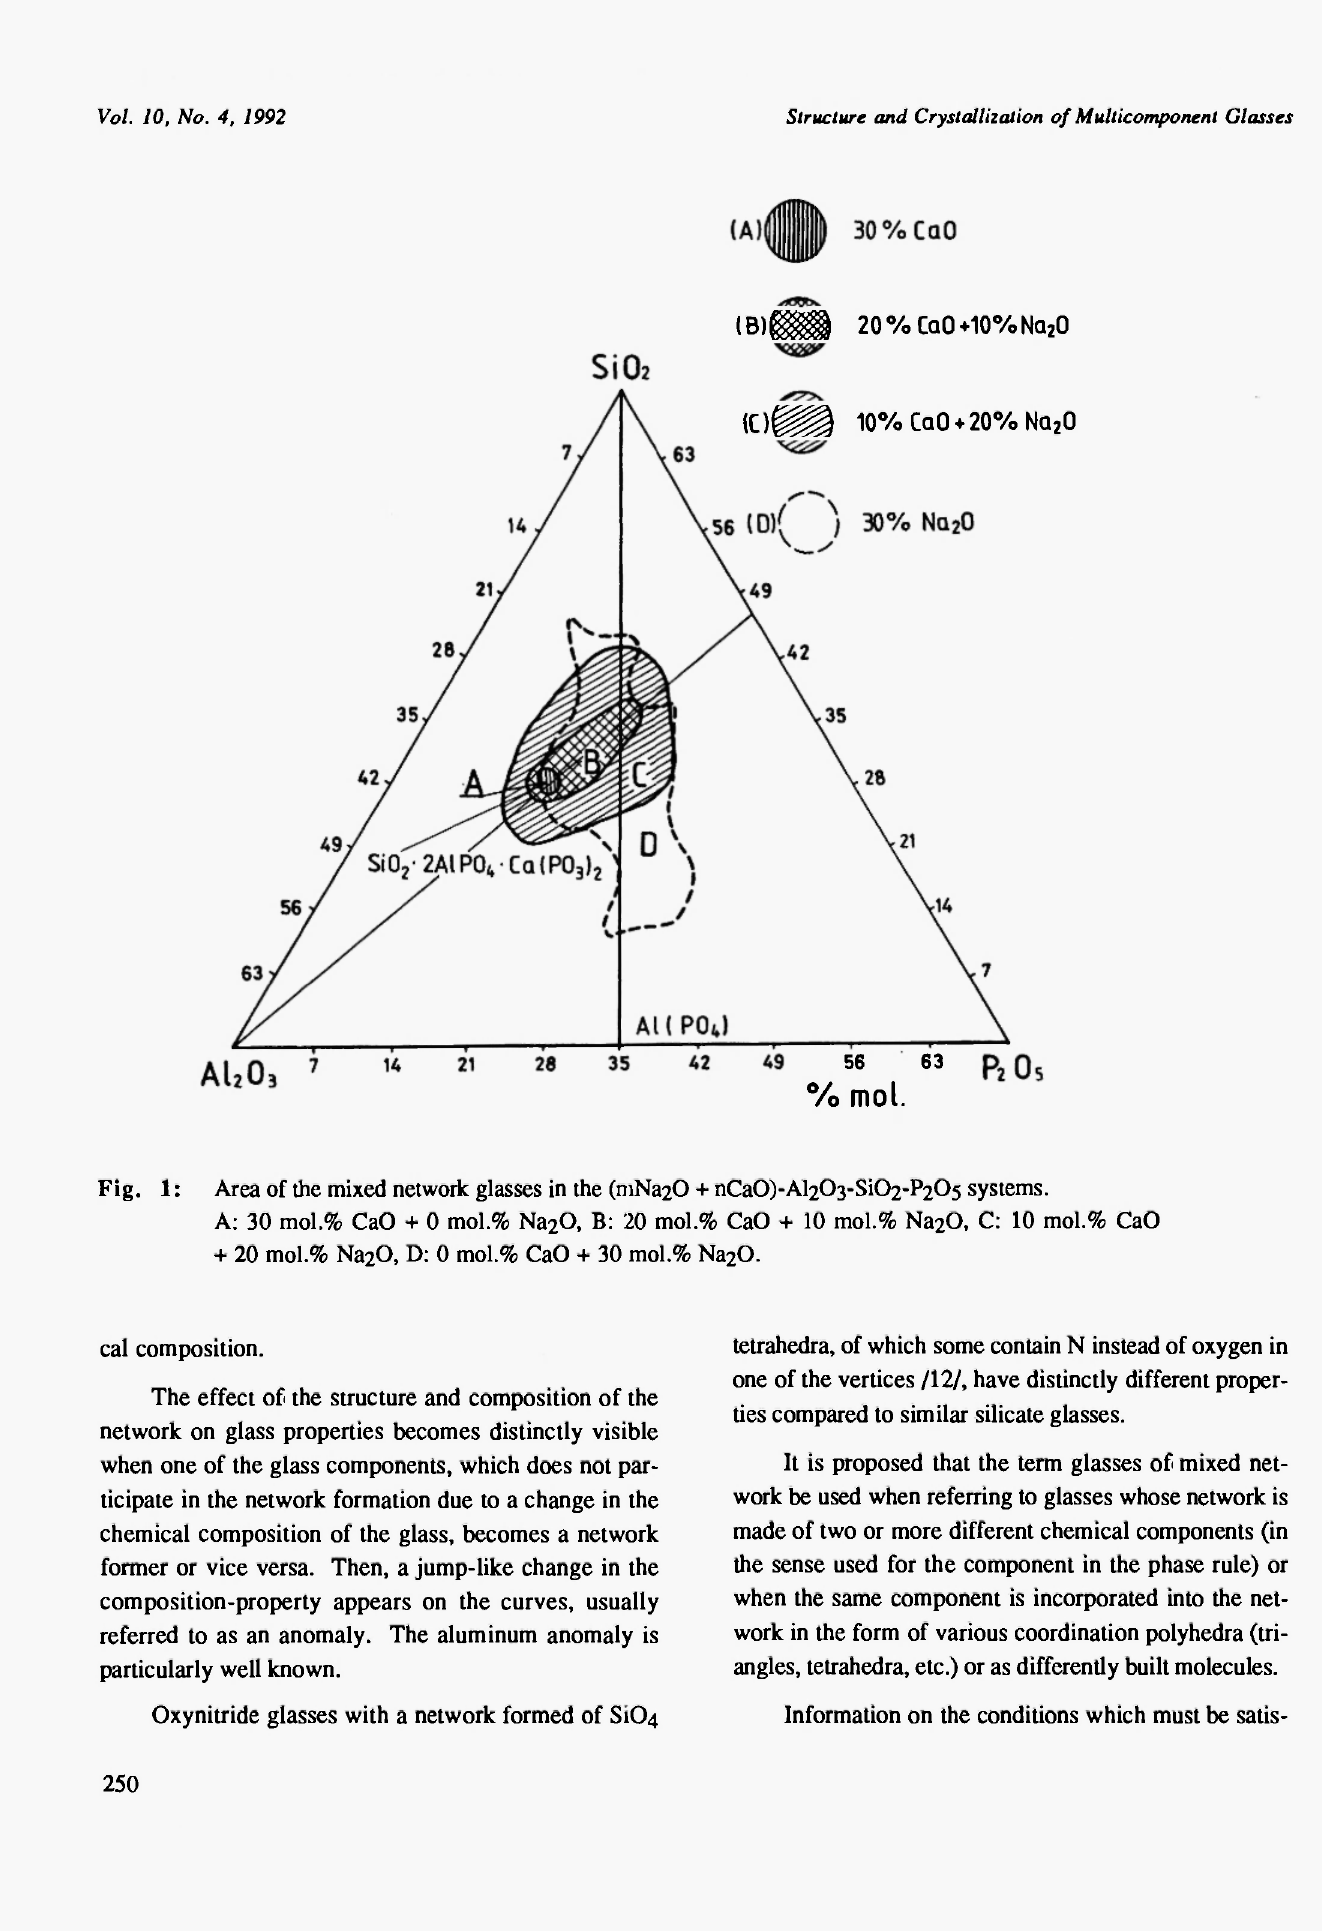
1: Area of the mixed network glasses in the (niNa20 + nCa0)-Al203-SiC>2-P205 systems. A: 30 mol.% CaO + 0 mol.% Na20, B: 20 mol.% CaO + 10 mol.% Na20, C: 10 mol.% CaO + 20 mol.% Na20, D: 0 mol.% CaO + 30 mol.% Na20.